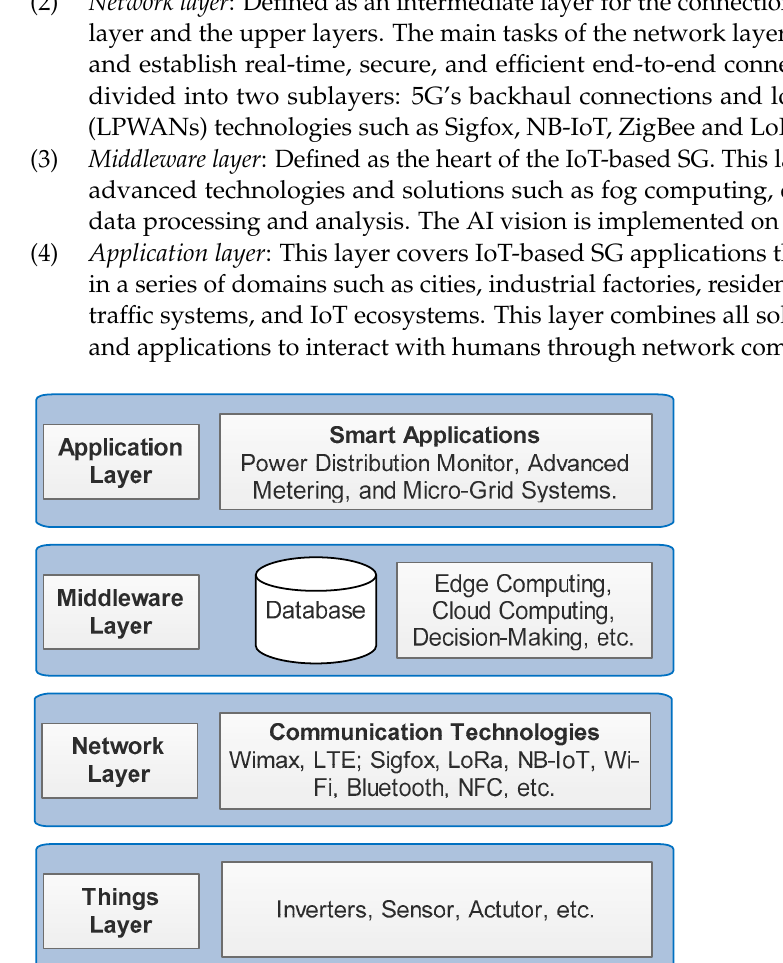
Figure 4. The all-in-one computing architecture for IoT-based SG.